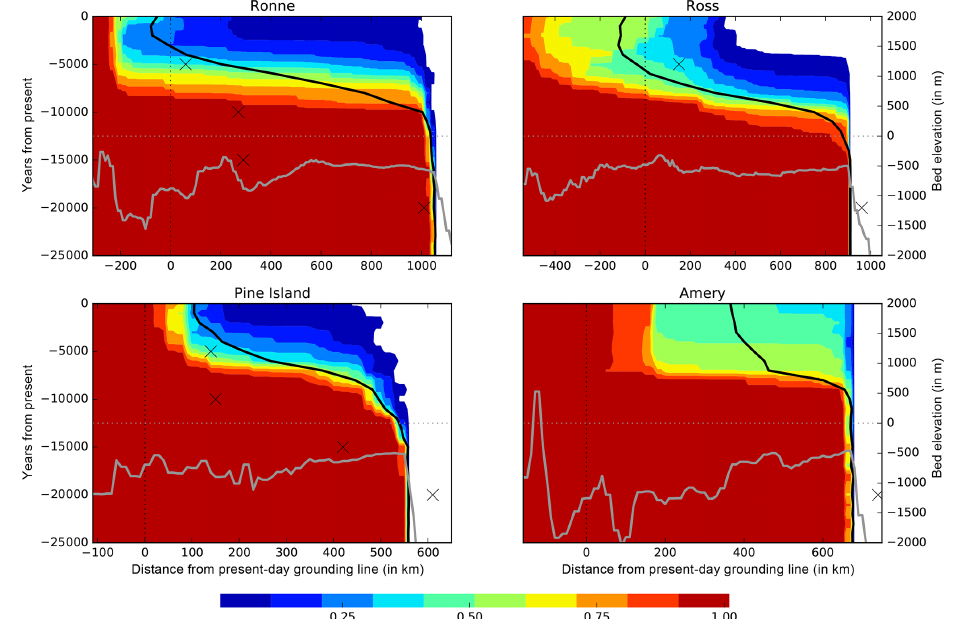
Figure 8. Ensemble score-weighted grounded ice cover along transects trough Weddell, Ross, Amundsen and Amery Ice Shelf basins over the last 25kyr simulation period ( y axis in left panels; compare to Fig. D5 in Pollard et al., 2016). Grounded areas which are covered by all simulations are indicated by value 1 (red), while blueish colors indicate areas which are covered only by some simulations (or those with low scores). Grounding line in the Ross Sea and Weddell Sea sector is found inland of its present location (vertically dotted) within the last 10kyr simulation time in about 50% and 75% of score-weighted simulations, respectively. The score-weighted mean curve (black) reveals re-advance of the grounding line of up to 100km in about 20% of the score-weighted simulations, both in the Ross and Weddell Sea sector, as discussed in Kingslake et al. (2018). Such behavior is not found in the Pine Island trough, where grounding-line retreat stops in 90% of the simulations at about 200km downstream of its present-day location. This is similar in the Amery Ice Shelf, where in 30% of score-weighted simulations the ice shelf does not retreat at all from its LGM extent. Bed topography (Bedmap2; Fretwell et al., 2013) along the transect is indicated as grey line with respect to y axis in the right panels. For all four troughs, the data type TROUGH is evaluated for the two time slices, corresponding to LGM conditions (20kyrBP; cross) and present